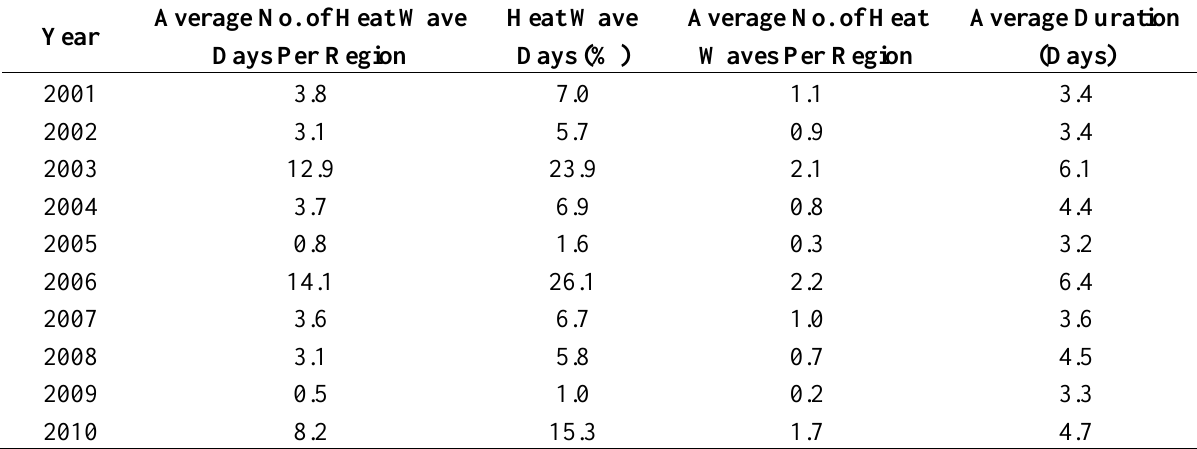
Table 3. Heat wave statistics for 2001–2010: Average number of heat wave days per region, percentage of annual heat wave days compared to the total number of heat wave days in the period 2001–2010, average number of heat waves per region, and annual average heat wave